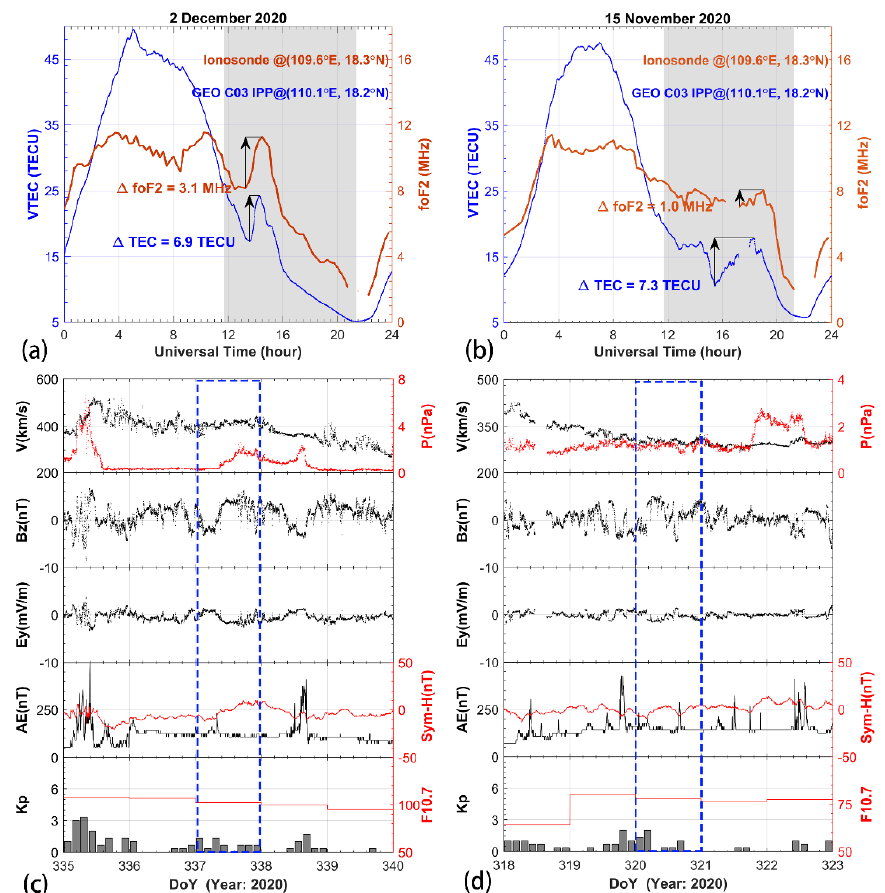
Figure 2. Temporal variations of GEO TEC and foF2 values on ( a ) 2 December 2020 and ( b ) 15 November 2020. The blue line plots the values of GEO TEC and orange line gives the values of foF2. The gray-shaded area illustrates local nighttime. The solar and geomagnetic activity indices within 5 days around ( c ) 2 December (DoY 337) 2020 and ( d ) 15 November (DoY 320) 2020, respectively. Shown from top to bottom of panels ( c , d ) are solar wind velocity and dynamic pressure, interplanetary magnetic field Bz component, interplanetary electric field Ey component, AE and SYM-H indices, and Kp and F10.7 indices. Blue boxes in panels ( c , d ) frame out the time range of 2 December